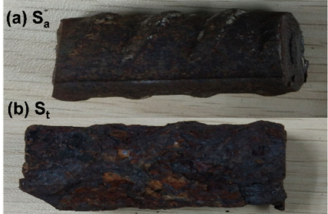
Figure 10. Steel samples in ( a ) The atmospheric zone (Sa) and ( b ) The tidal zone (St).